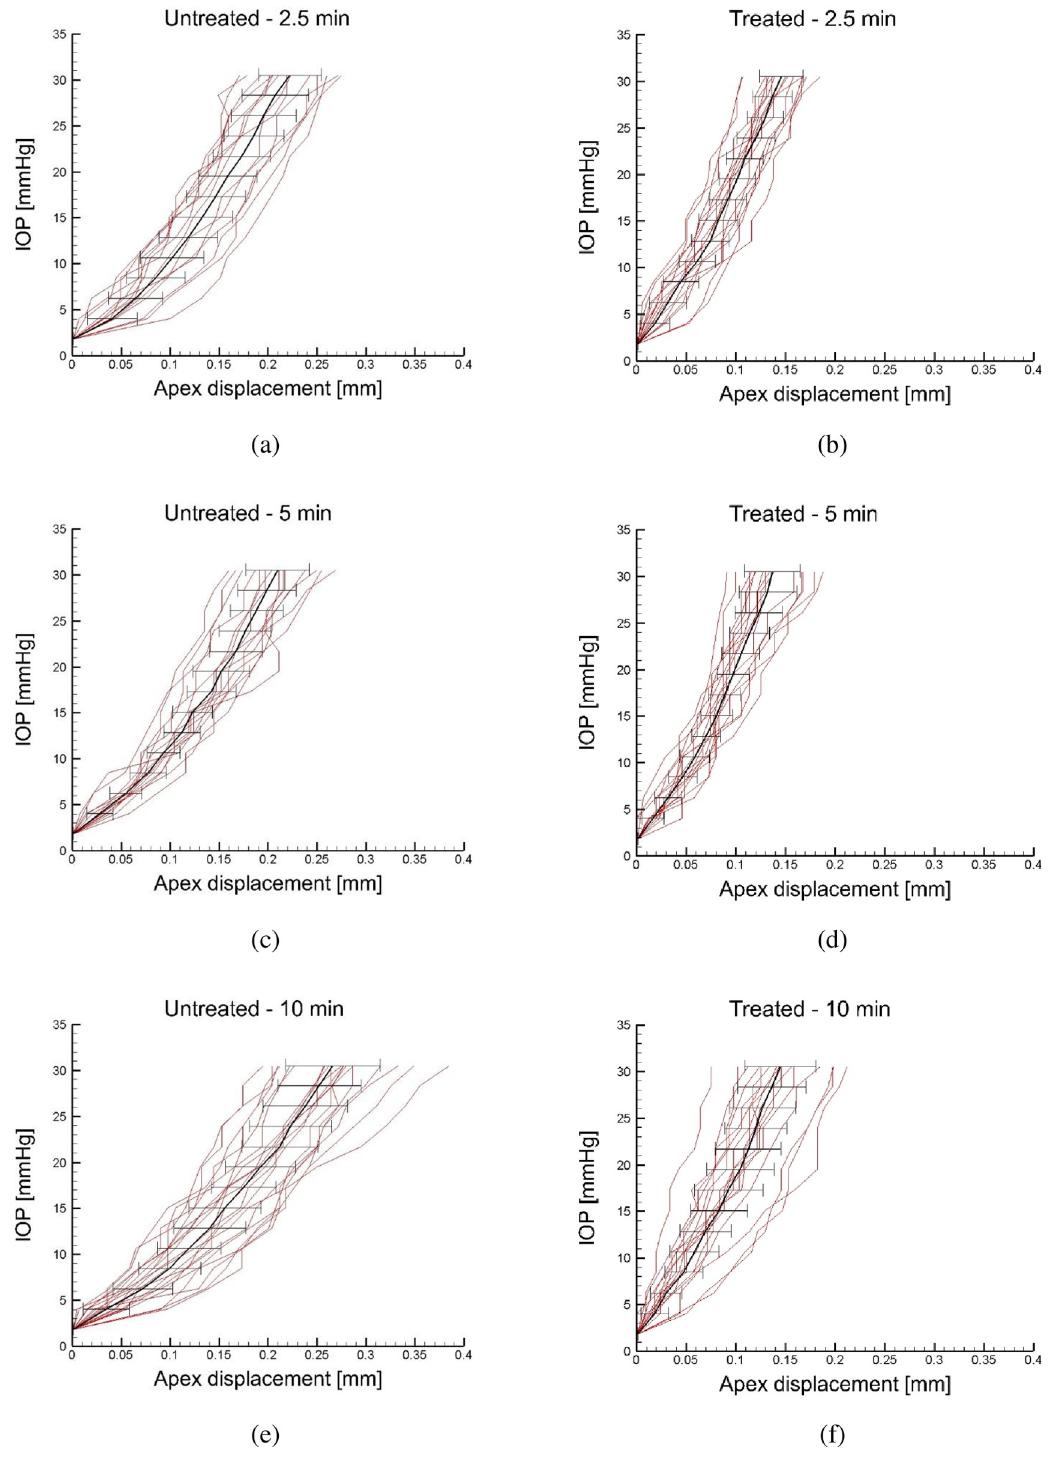
Fig 5. Inflation tests for the cornea groups irradiated for shorter times, 2.5, 5 and 10 minutes, respectively. IOP versus apex displacement: comparison between the untreated corneas and the treated corneas. Average values and error bars are also reported.